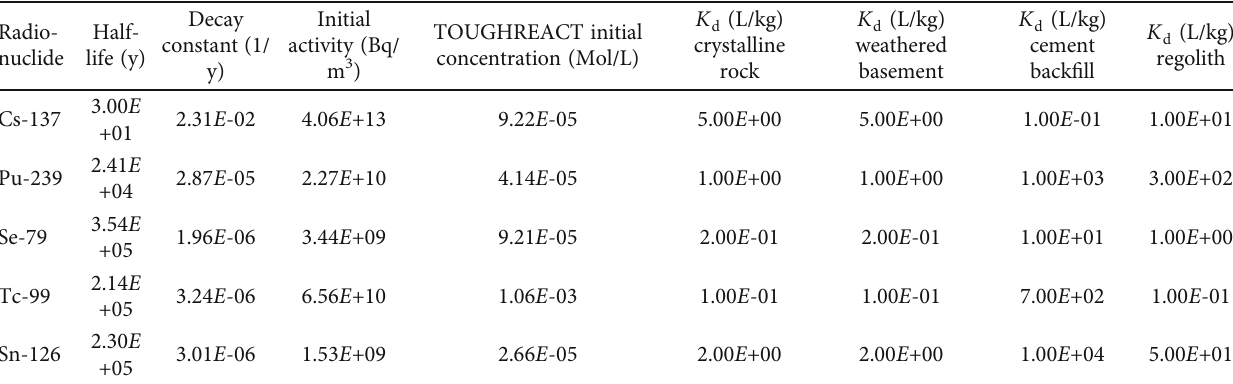
Table 2: Properties of the radionuclides considered in this study. Data source is from Mallants and Beiraghdar [9] and [51].